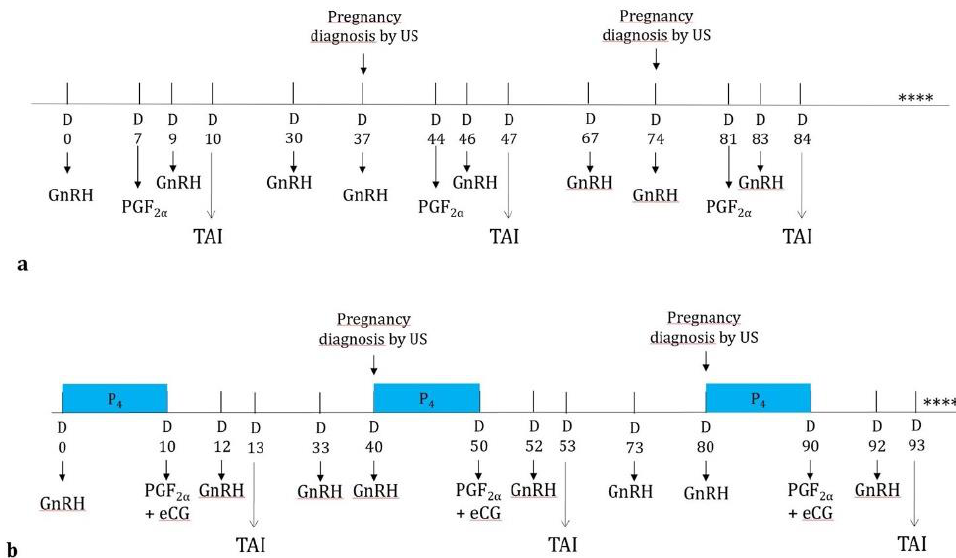
Figure 1. Ovsynch ( a ) and progesterone based ( b ) protocols for re-synchronization of ovulation in primiparous buffaloes. (**** this schedule was repeated for a maximum of 4 times).